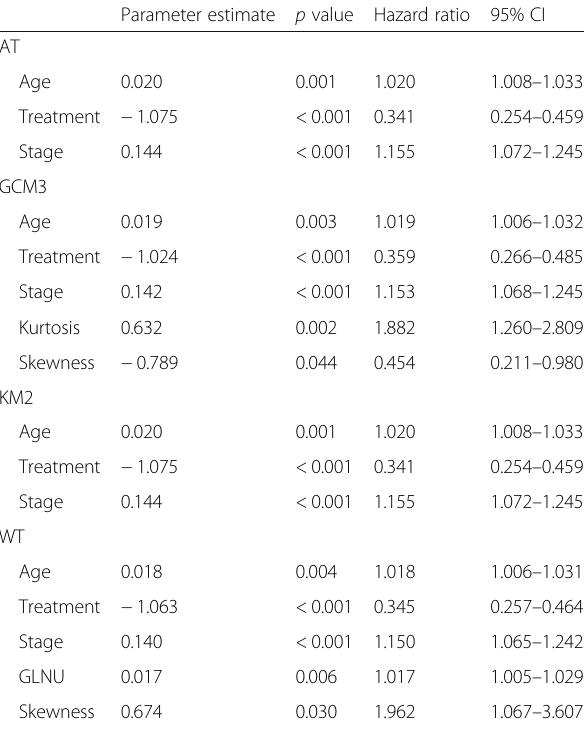
Table 3 Baseline characteristics of patient cohort Table 4 Final output of prognostic models derived using AT, GCM3, KM2 and WT PET segmentation methods